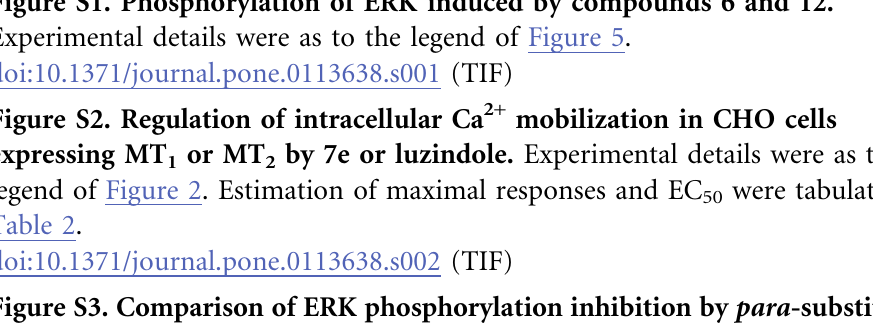
Figure S1. Phosphorylation of ERK induced by compounds 6 and 12. Experimental details were as to the legend of Figure 5. Figure S2. Regulation of intracellular Ca 2 + mobilization in CHO cells expressing MT or MT by 7e or luzindole. Experimental details were as to the 1 2 Table 2. Figure S3. Comparison of ERK phosphorylation inhibition by para -substituted benzyloxyl derivatives. Experimental details were as to the legend of Figure 7.